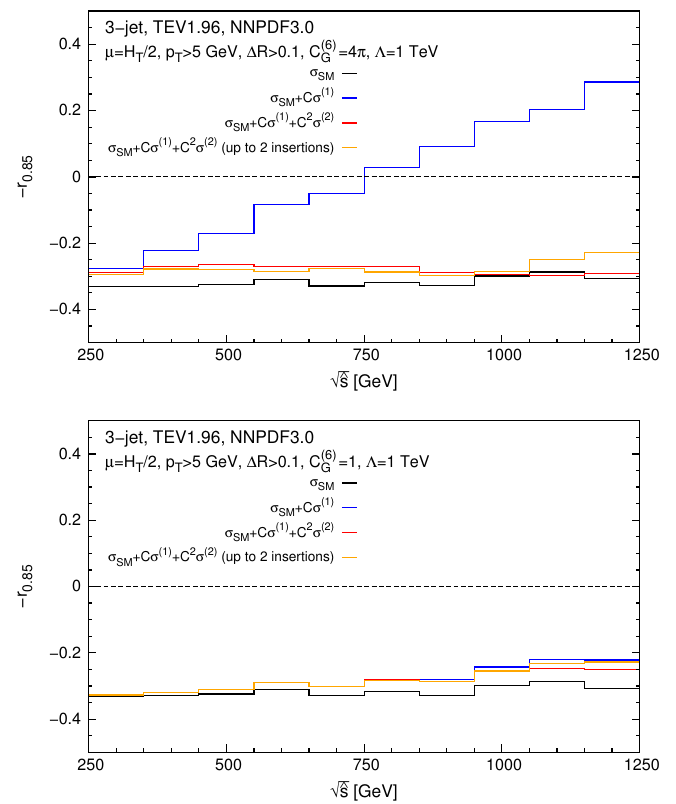
Figure 15 . Distribution of r 0 : 85 as de(cid:12)ned in eq. (3.4), as a function of the centre-of-mass energy in three-jet production with the cuts de(cid:12)ned in eq. (3.2), and for C G = 4 (cid:25) (upper plot) and C G = 1 (lower